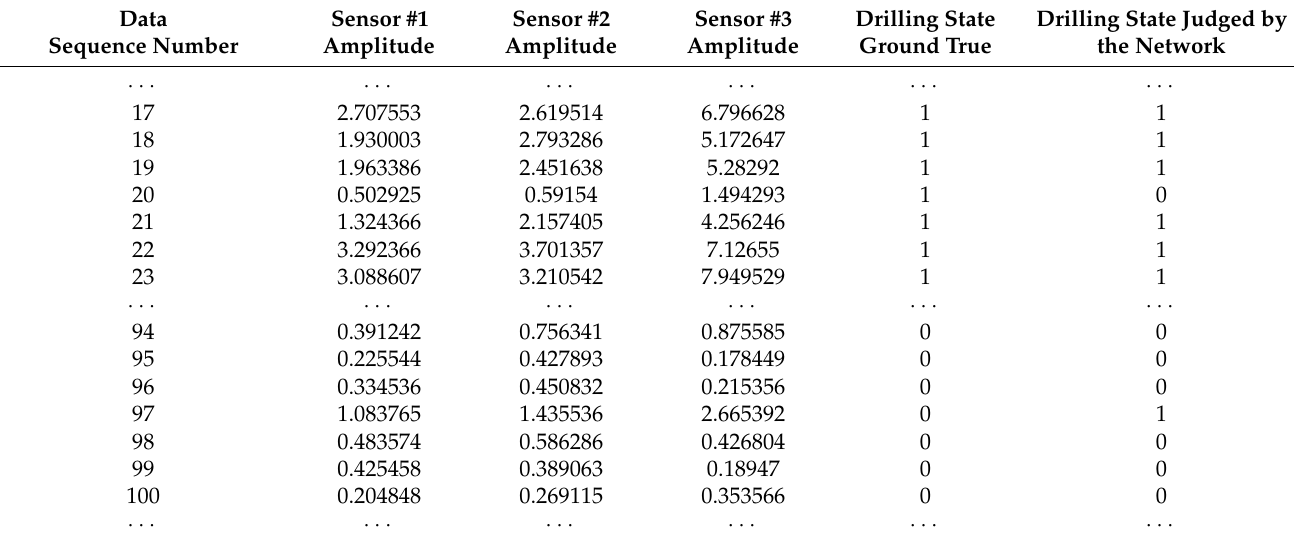
Table 3. Part of the outlier data points in the Test #1